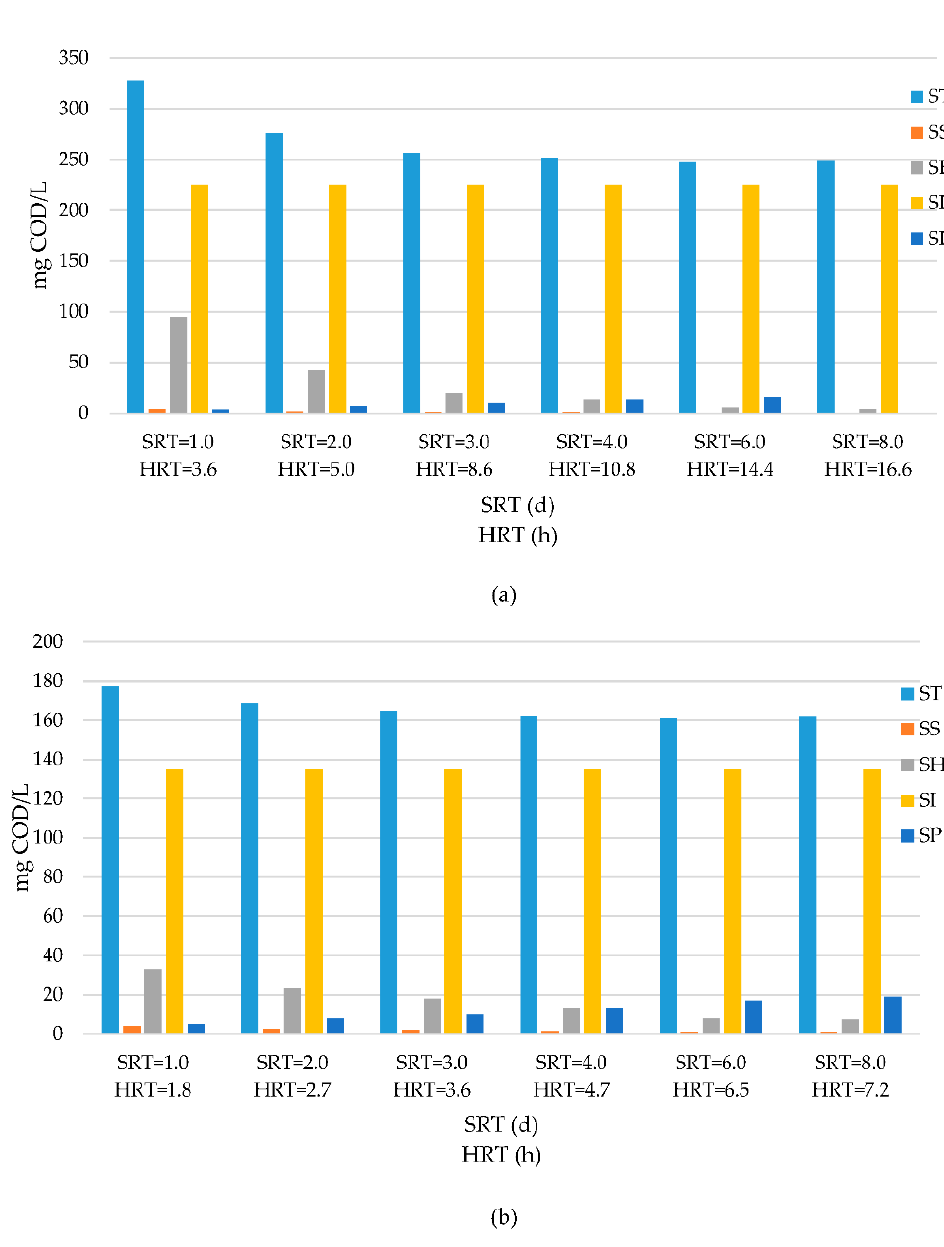
Figure 4. Effluent COD fractionation of textile wastewater operated at different HRTs in STEP 1 for ( a ) ASM1 and ( b ) MASM.